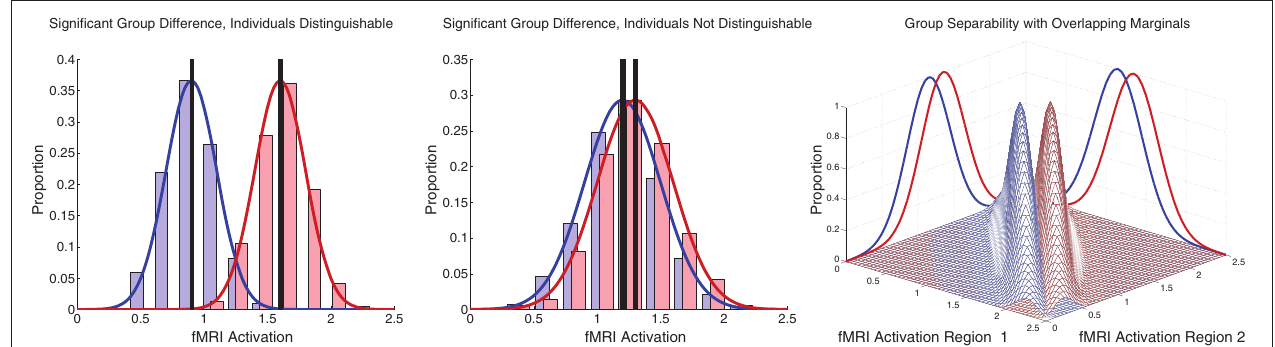
FIGURE 7 | Illustration of group differences vs. individual differences. Left and middle panels show simulated fMRI activation levels from an arbitrary brain region for two groups (blue and red) of 1000 participants each. Frequency histograms for participants’ activation levels appear as pale blue and pale red bars. The actual Gaussian distributions from which participants were drawn are shown as dark blue and dark red curves. Black vertical rectangles (which may appear as thick black lines) show 95% confidence intervals of average activation across each group. Group comparisons between blue and red average activation levels are significant in both panels ( left : p (cid:5) machine precision, t = 78 . 7, df = 1998; middle : p = 2 × 10 − 12 , t = 7 . 1, df = 1998). The high statistical significance in both cases derives from the large number of participants, which allows us to estimate the